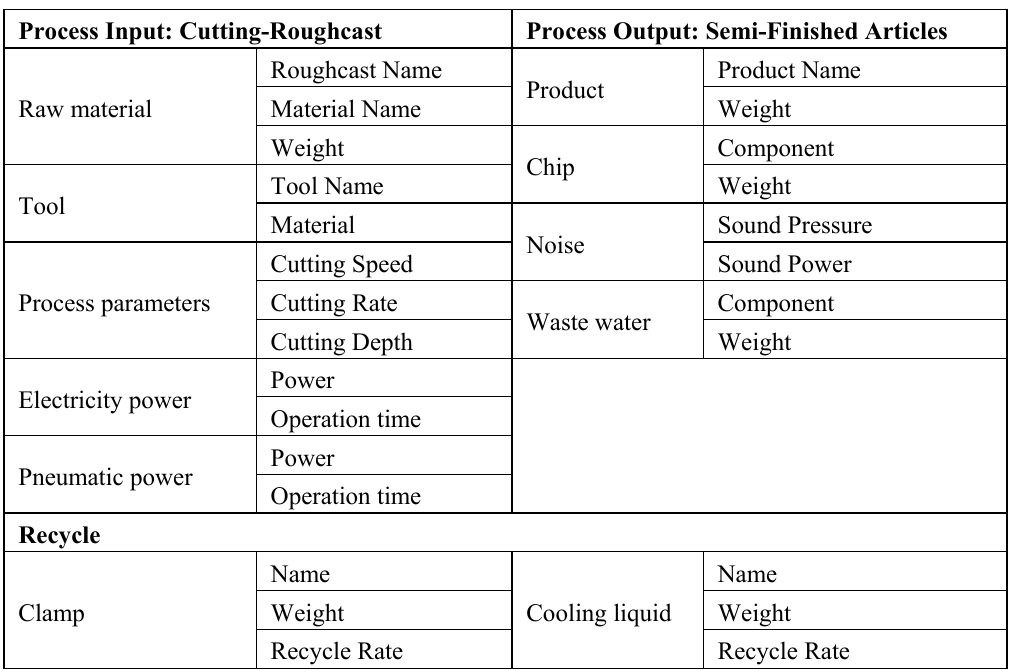
Table 1. Analysis checklist of the cutting